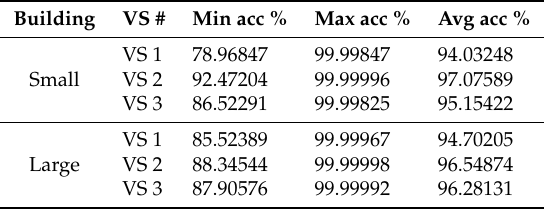
Table 1. Accuracy results of the deployed virtual sensors.